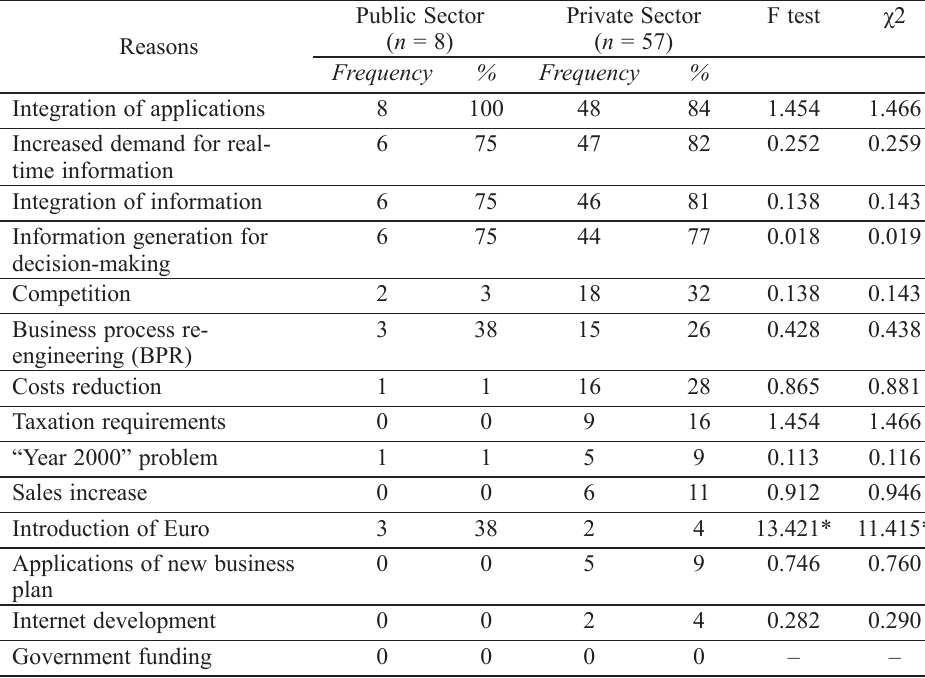
Table 3. Reasons for ERP implementation in Portuguese public/private organizations